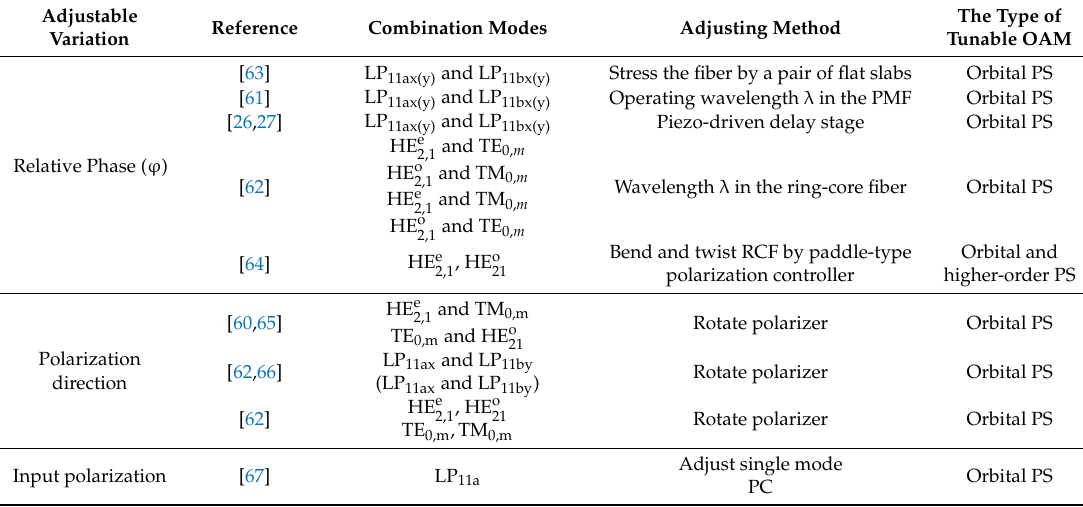
Table 2. The fiber-based generation methods